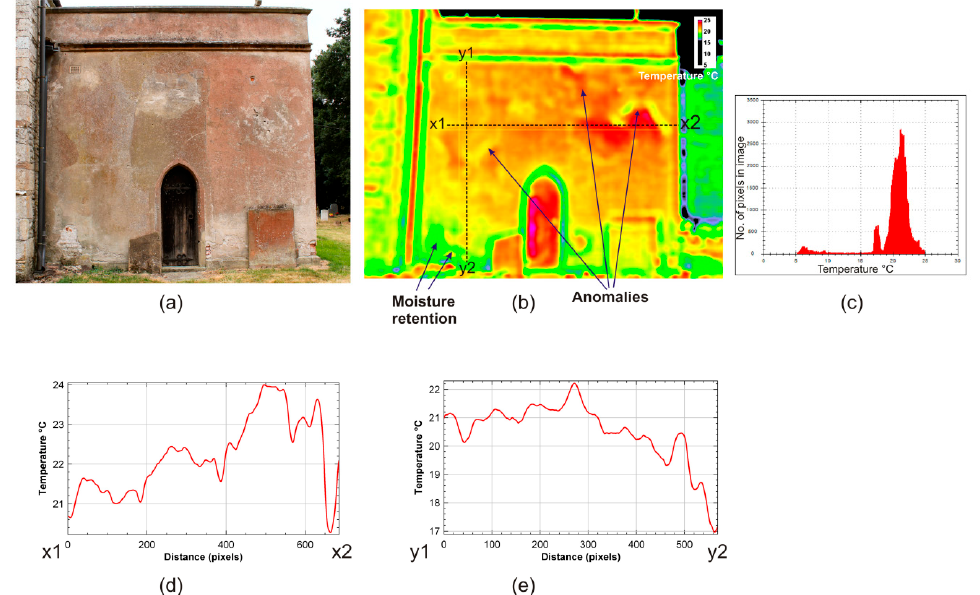
Figure 1. Averham church, Nottinghamshire, U.K. showing the east side of the mausoleum: ( a ) the control image as seen by the unaided eye; ( b ) a thermal image showing potential archaeological anomalies as well as moisture movement in the render covering; ( c ) the temperature distribution in the thermal image; ( d , e ) linear temperature plots across the target illustrating thermal variations; the lower values in ( e ) indicate rising damp in the render.